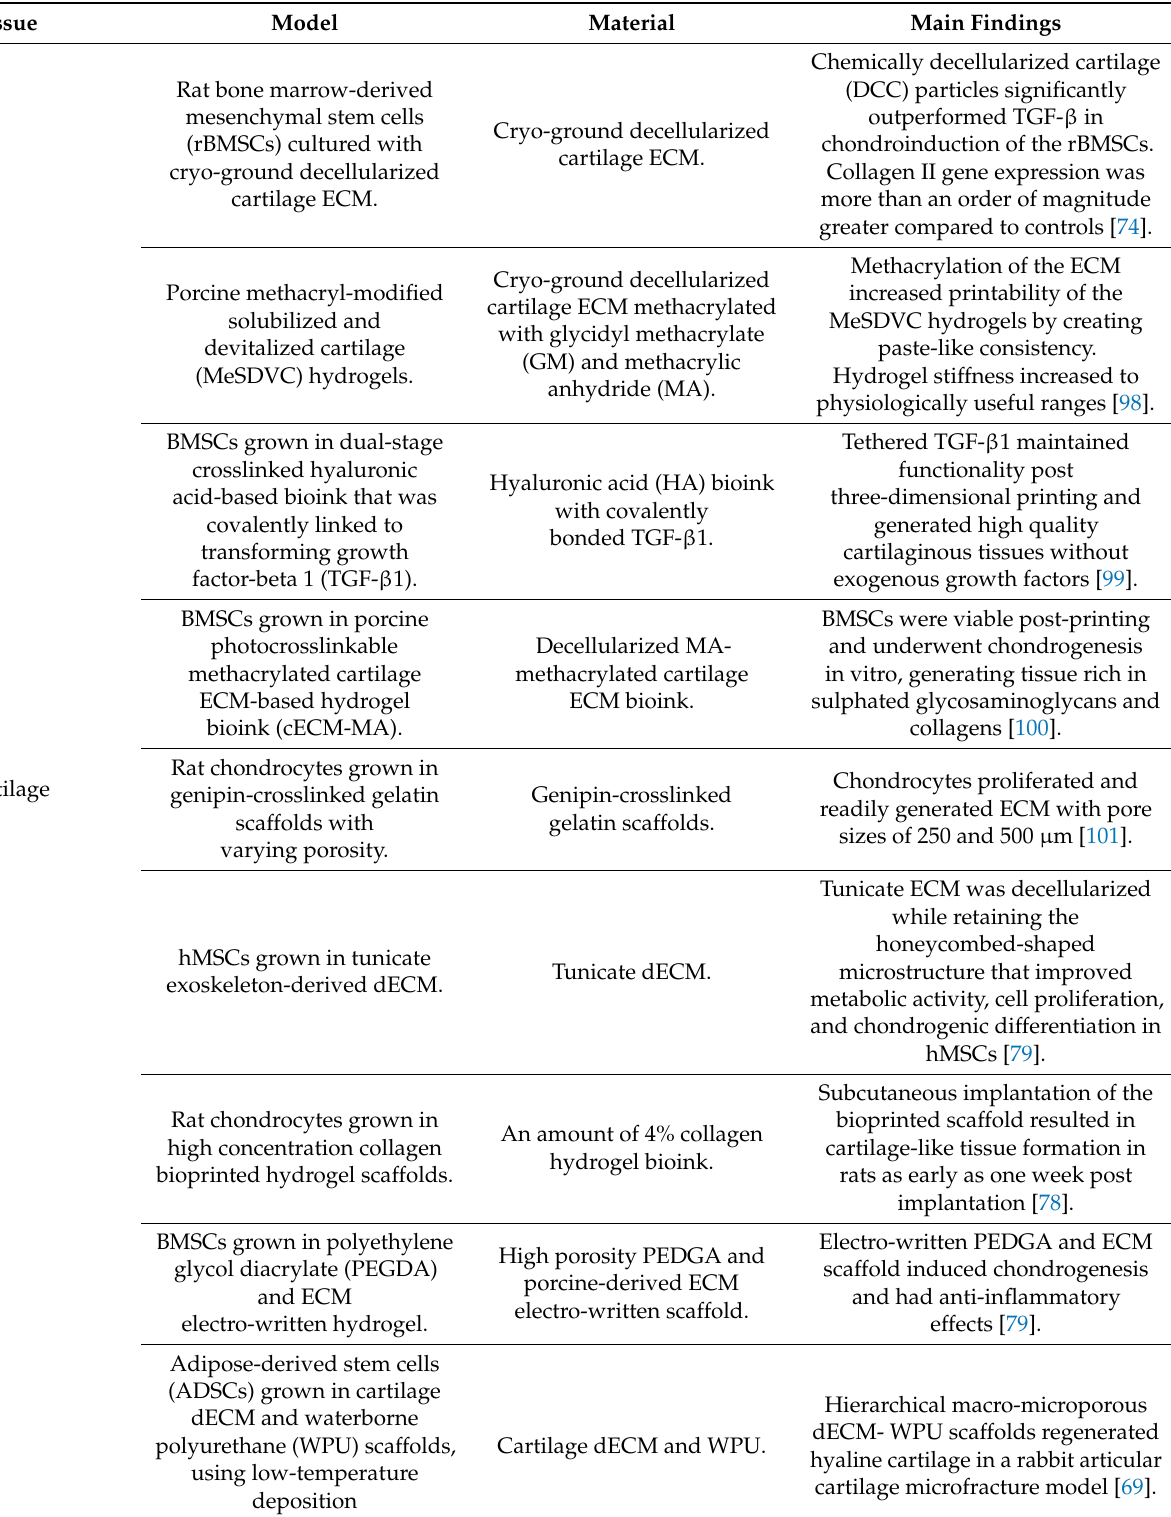
Table 2. Recent and noteworthy studies focused on cell–ECM–material interactions in